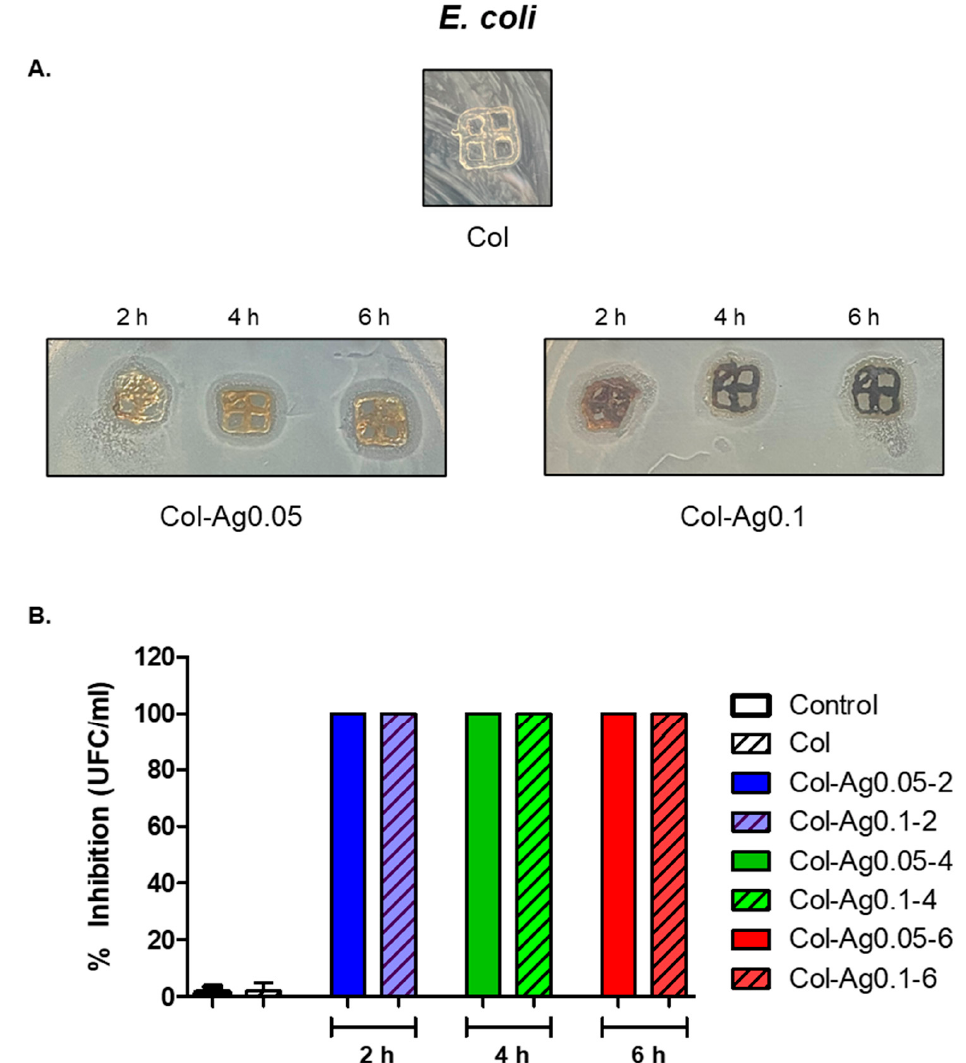
Figure 9. Antimicrobial activity of 3D-printed Col and Col-Ag gels against E. coli . ( A ) Disk diffusion method. ( B ) Percentage of growth inhibition, evaluated by the dilution method.